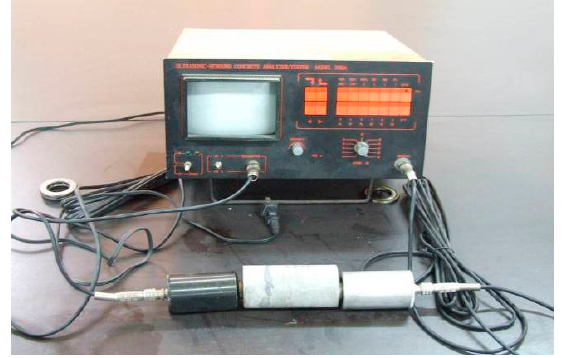
Figure 3. UTA2001A ultrasonic inspection monitor.